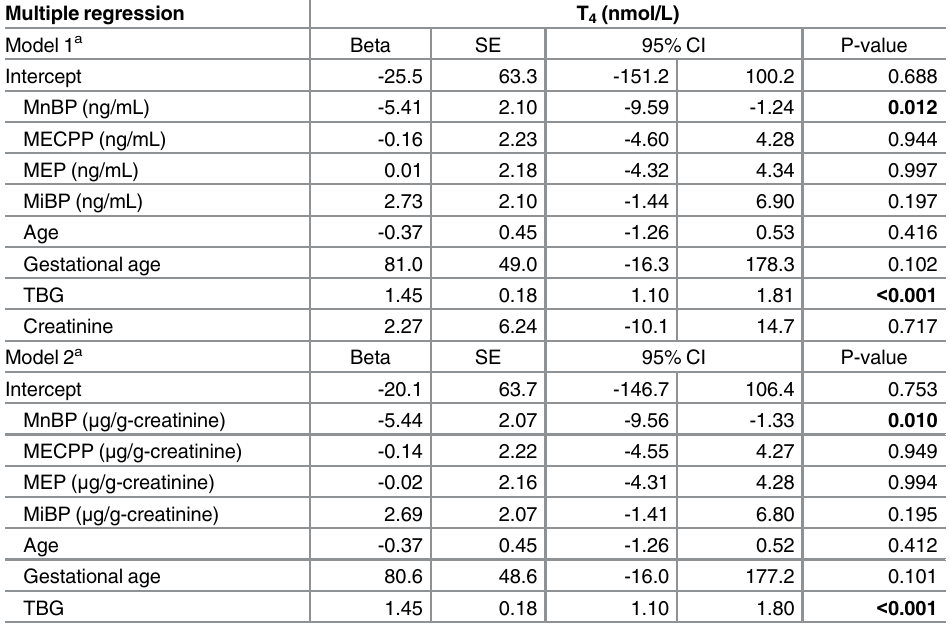
Table 5. Multiple linear regression between serum T 4 and corresponding urinary phthalate metabo- lites (N = 97; T 4 : R 2 = 0.475). Multiple regression T 4 (nmol/L) Model 1